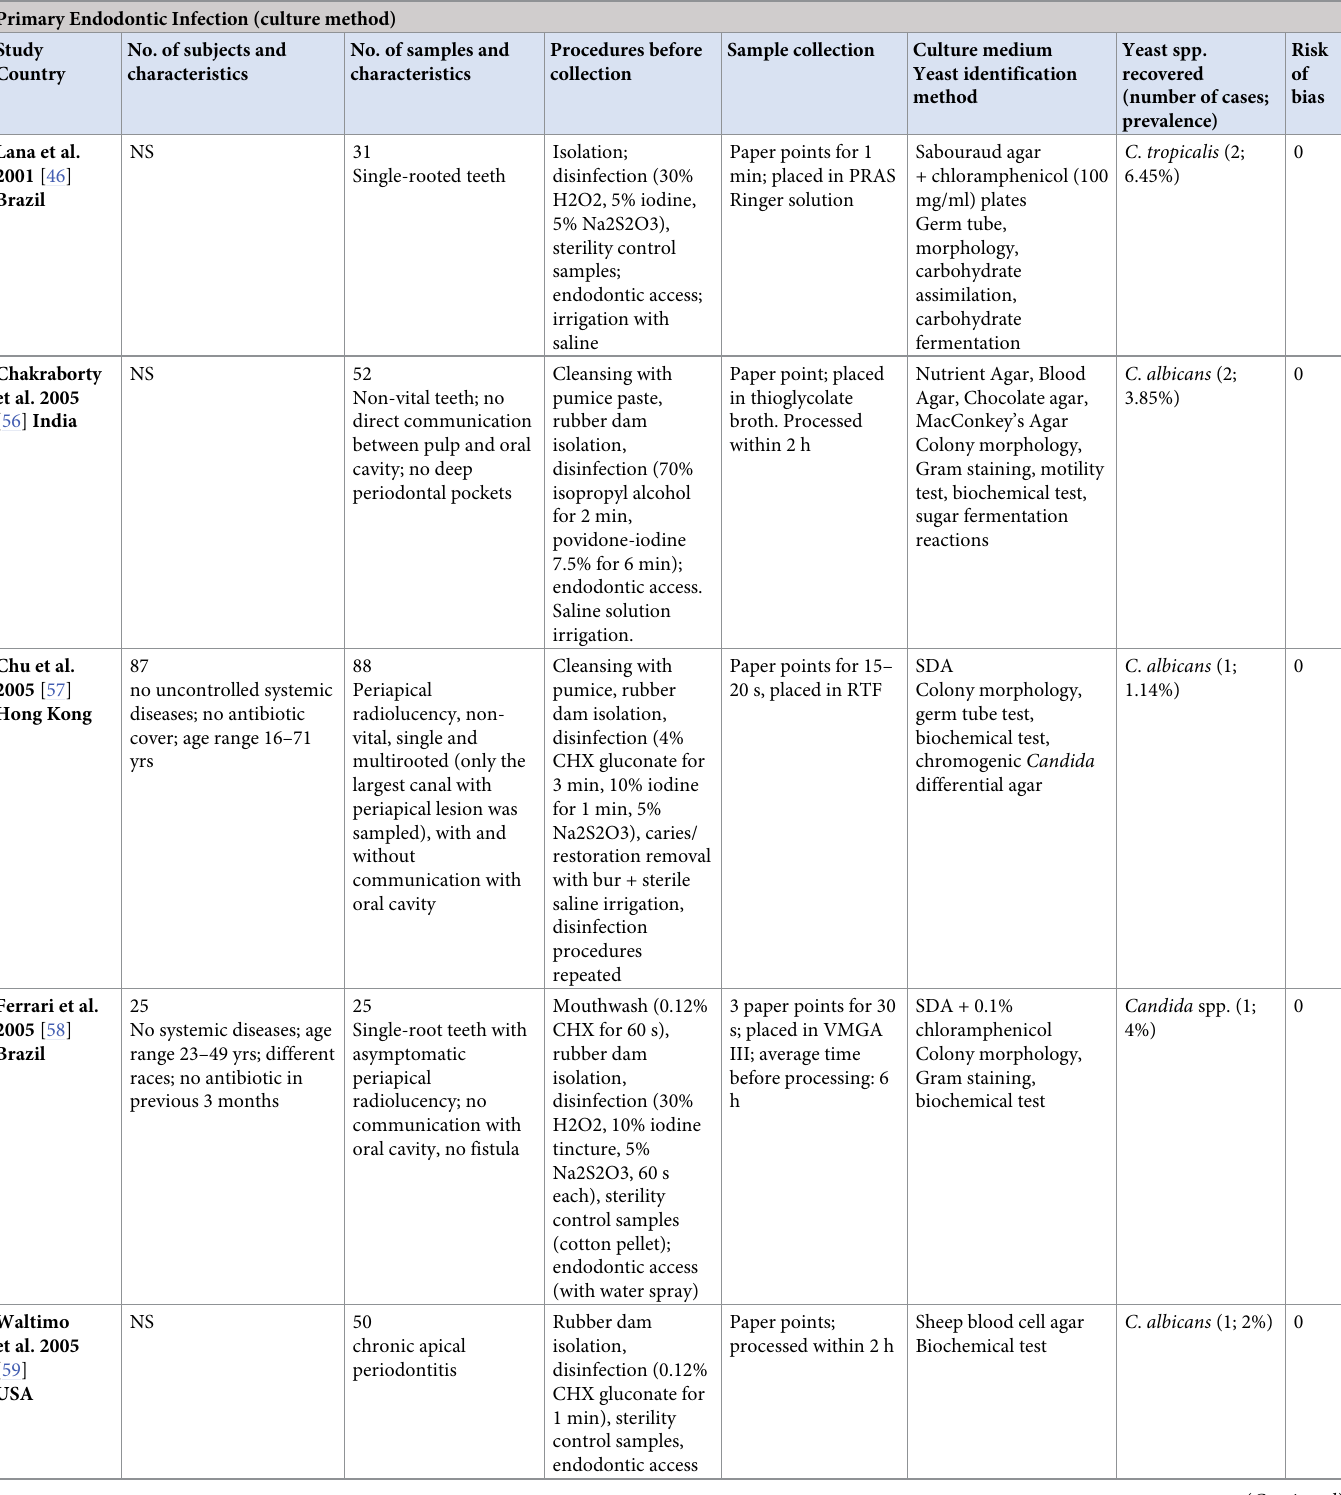
Table 1. Characteristics of the included studies using only culture methods for yeast identification, from primary endodontic